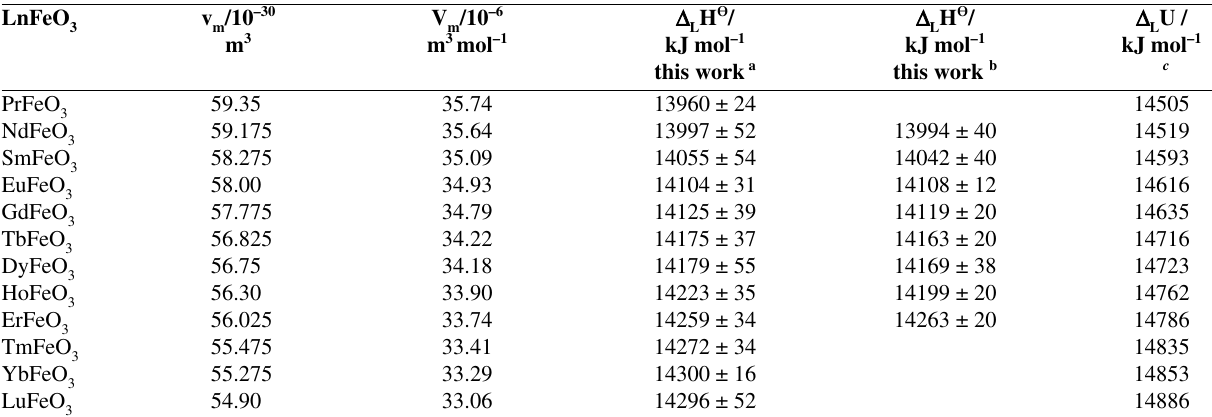
) and molar (V ) volumes and lattice enthalpies of lanthanide orthoferrites m m